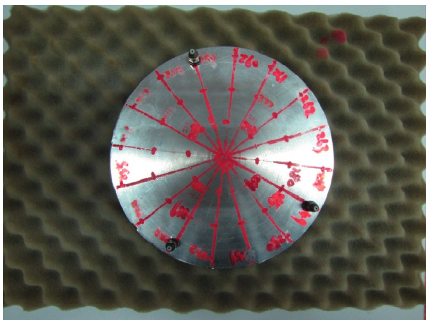
Figure 11: Test configuration of the cover.